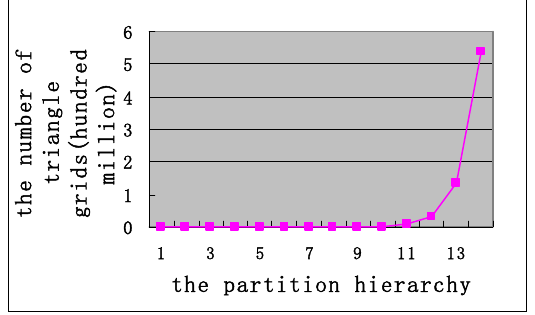
Figure 1 Correspondence between the number of triangle grids and the partition hierarchy